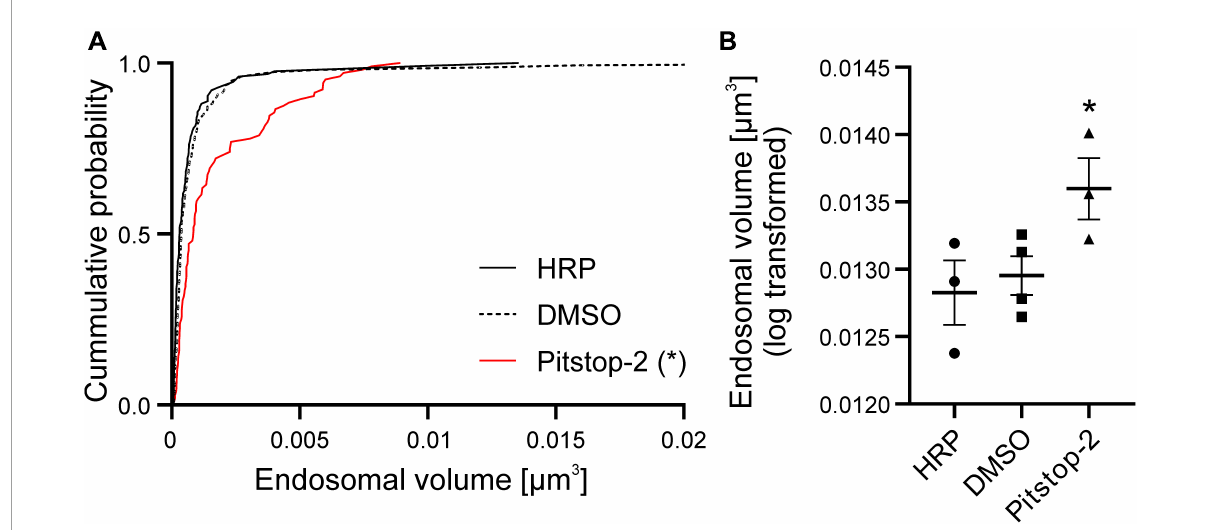
FIGURE4 The volume of large endosomes is increased at the calyx of Held upon application of Pitstop-2. (A) Cumulative probability plot of all large endosome volumes observed in the presence and absence of Pitstop-2 ( n = 104–152 endosomes from 3 to 4 calyces/group, 1 calyx/animal;